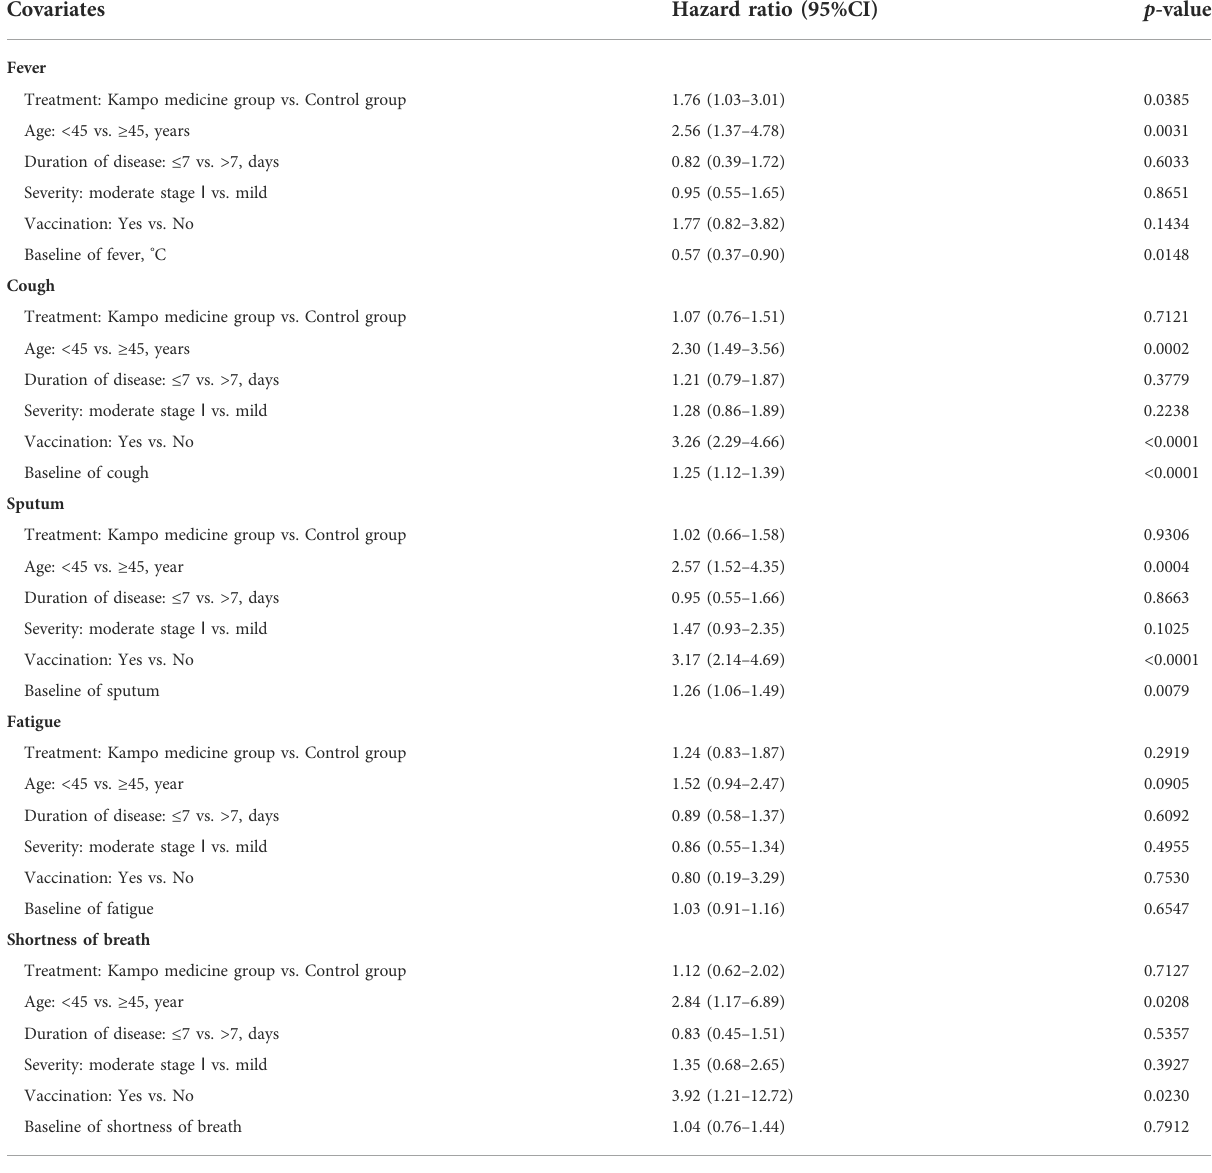
TABLE 3 Covariate-adjusted cumulative incidence of symptom relief when drop out due to worsening of symptoms was treated as a competing risk. Covariates Hazard ratio (95%CI) p -value